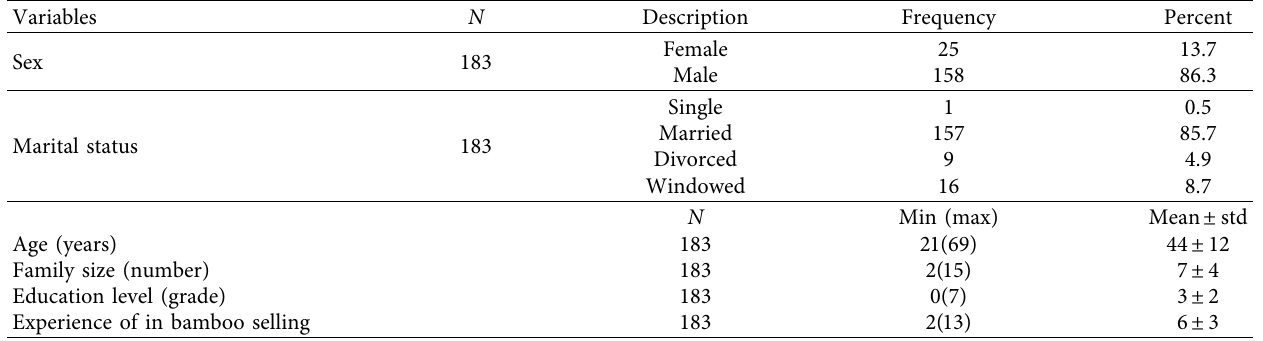
Table 2: Household and socioeconomics characteristic of sampled producer households.